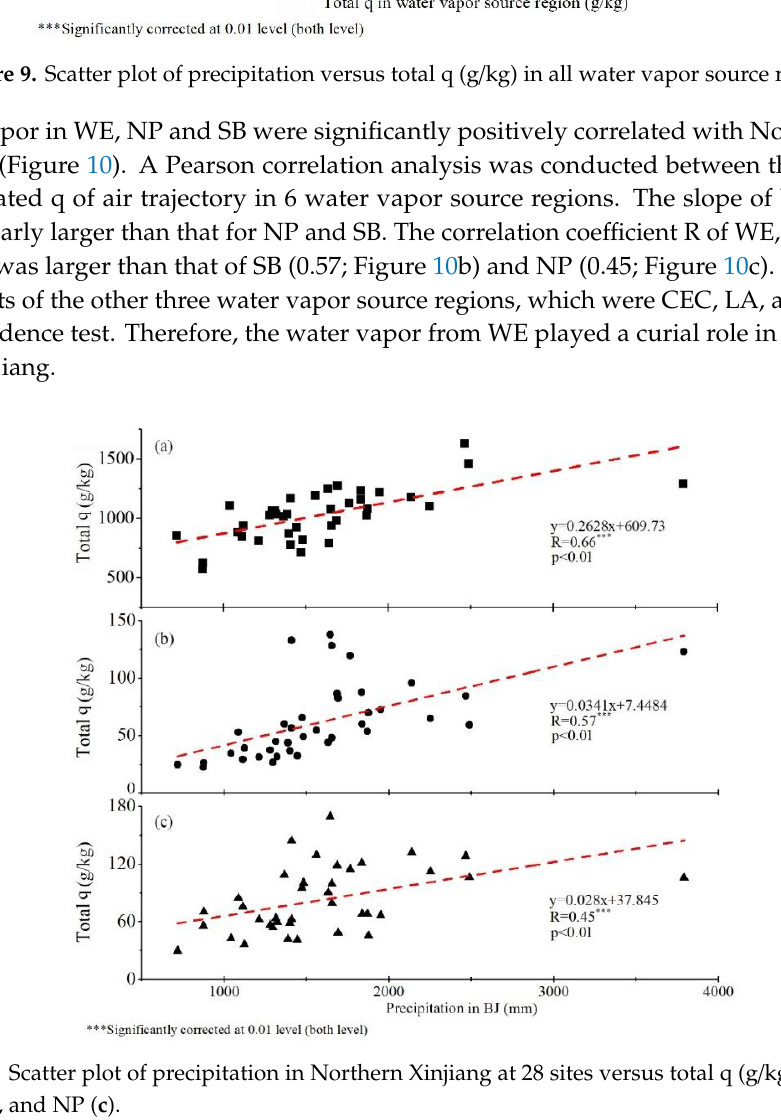
Figure 9. Scatter plot of precipitation versus total q (g/kg) in all water vapor source regions.